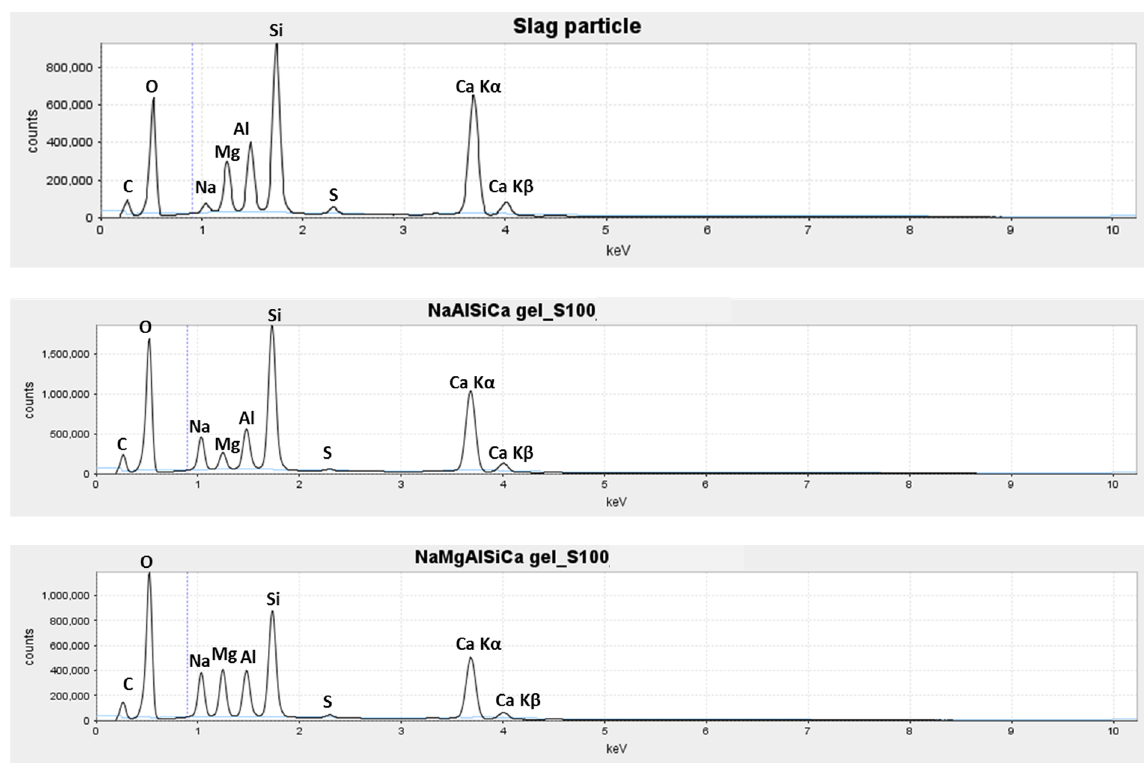
Figure 13. SEM-BSE images of the S100 microstructure (sealed cured paste for 28 days) and the compound domains of different phases.